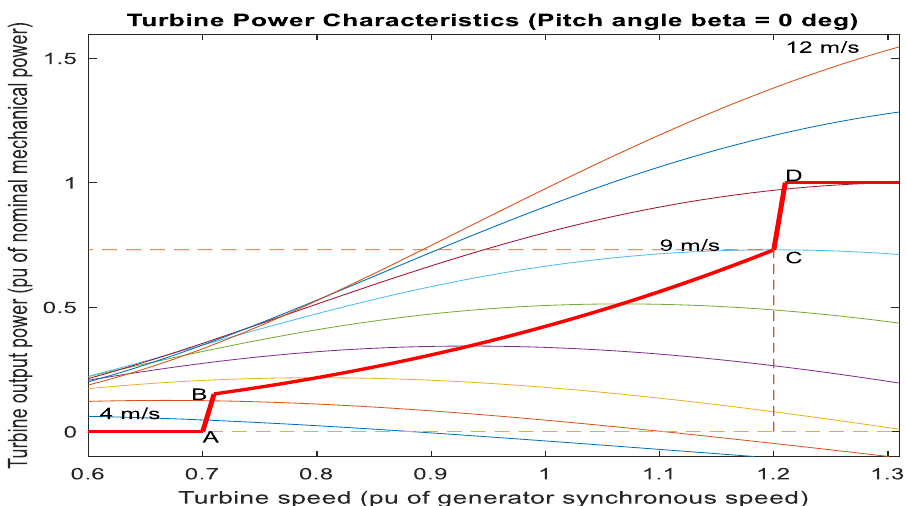
Figure 9 . DFIG wind turbine power curve. Figure 9. DFIG wind turbine power